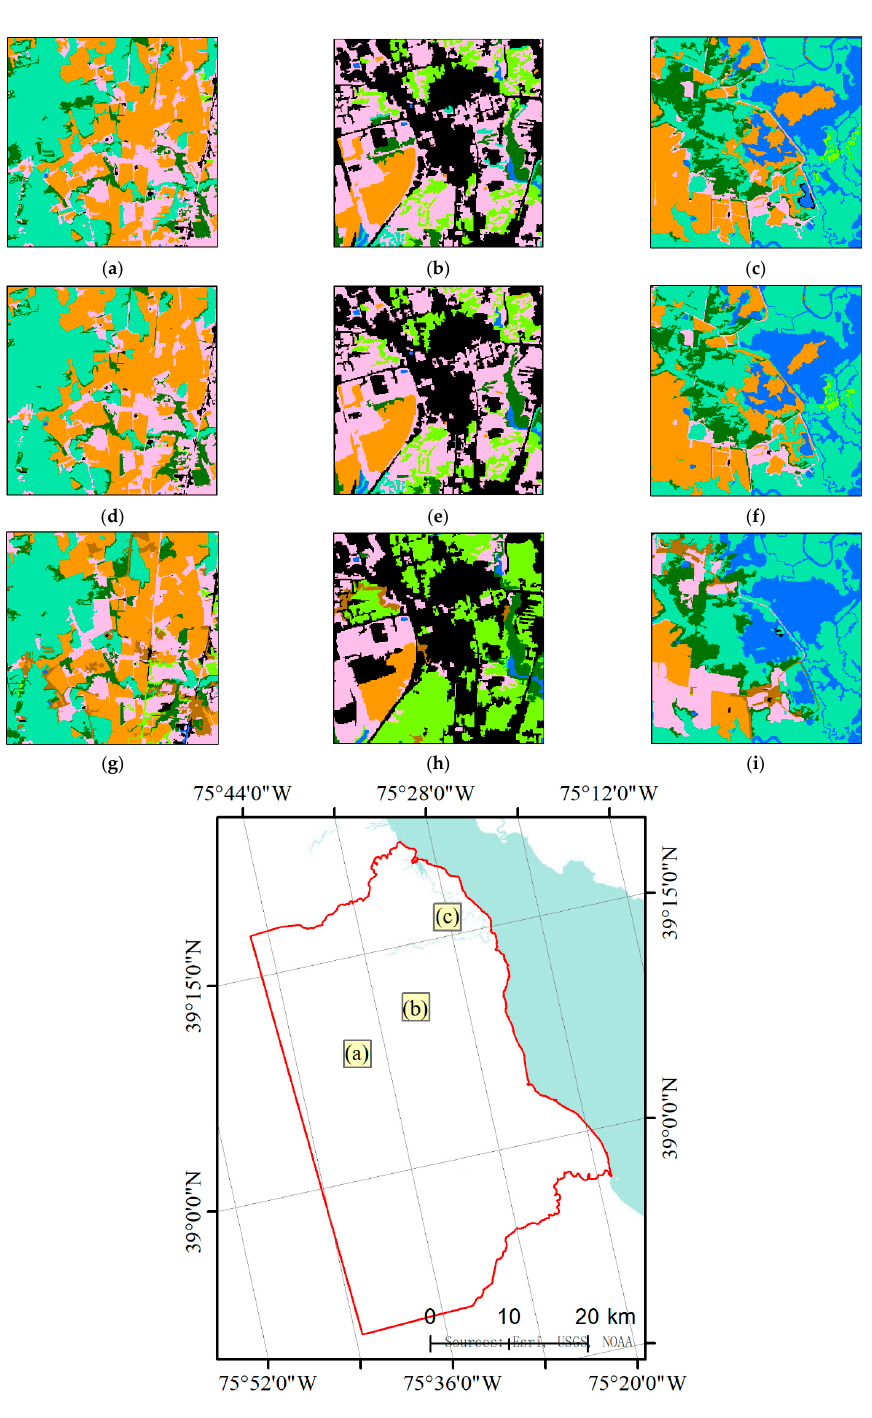
Figure 16. Details of the pre-classification land cover map versus the decision fusion land cover map. The three locations, shown at a larger scale, respectively contain ( a ) wetland and agriculture, ( b ) impervious and tree canopy, and ( c ) water and wetland, while ( d – f ) are the same regions with decision fusion results and ( g – i ) are the same regions with manually interpreted land cover. ( j ) is the location of the sample regions.